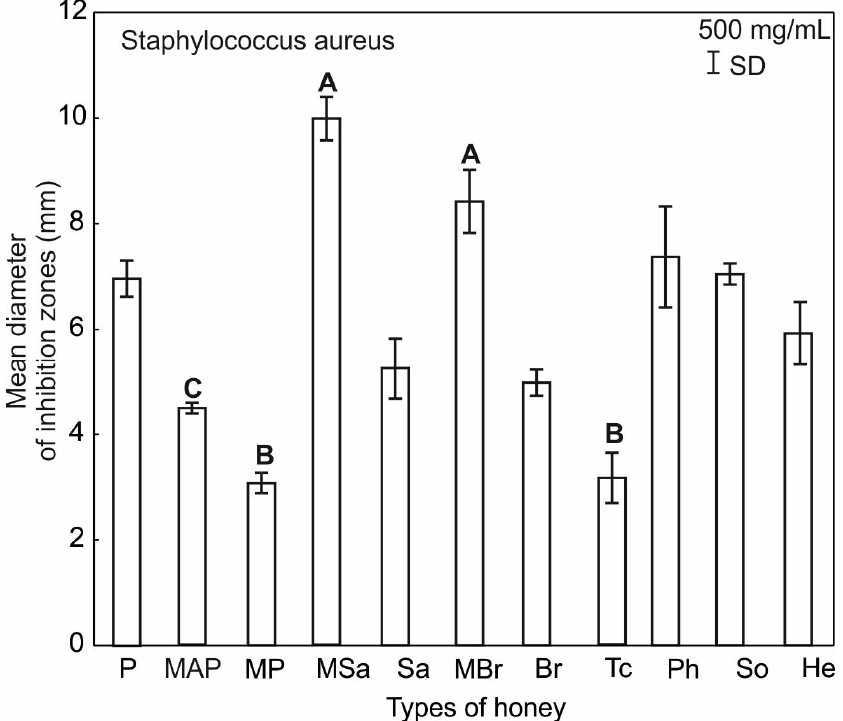
Figure 6. Results of the ANOVA Kruskal–Wallis H test for inhibition property of all tested honey types and their concentrations against S. aureus . Statistical differences are marked with different letters and their significance at p ≤ 0.001 with capital letters, p ≤ 0.05 with lowercase letters.